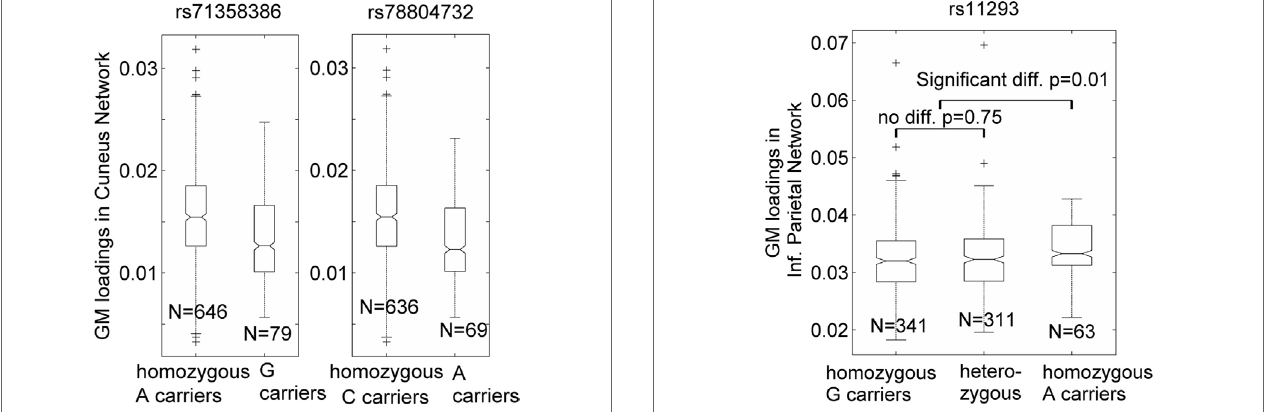
FigUre 3 | Single-nucleotide polymorphism rs11293’s association with an inferior parietal gray matter (GM) component. GM loadings are relative values without unit. In the box plots, the middle line is the median value, the top and bottom of each box are the 25th and 75th percentile values, the whiskers extend from the ends of the interquartile to the further values within 1.5 times the interquartile, and plus ( + ) signs show values that are more than 1.5 times the interquartile range away from the top or bottom of the box. The plot of medium and 25/75th percentile presents a similar overall pattern as the mean and standard deviation in these data.